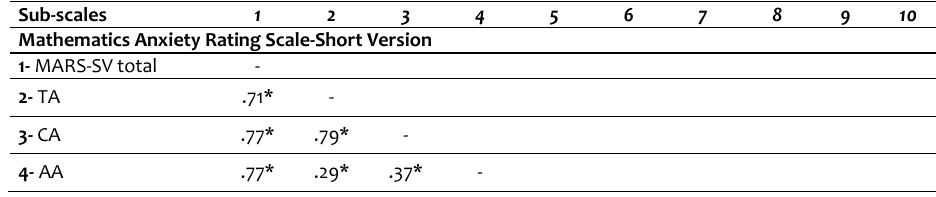
Table 2. MARS-SV, CMS-SV and GPA SCORE Correlation Matrix